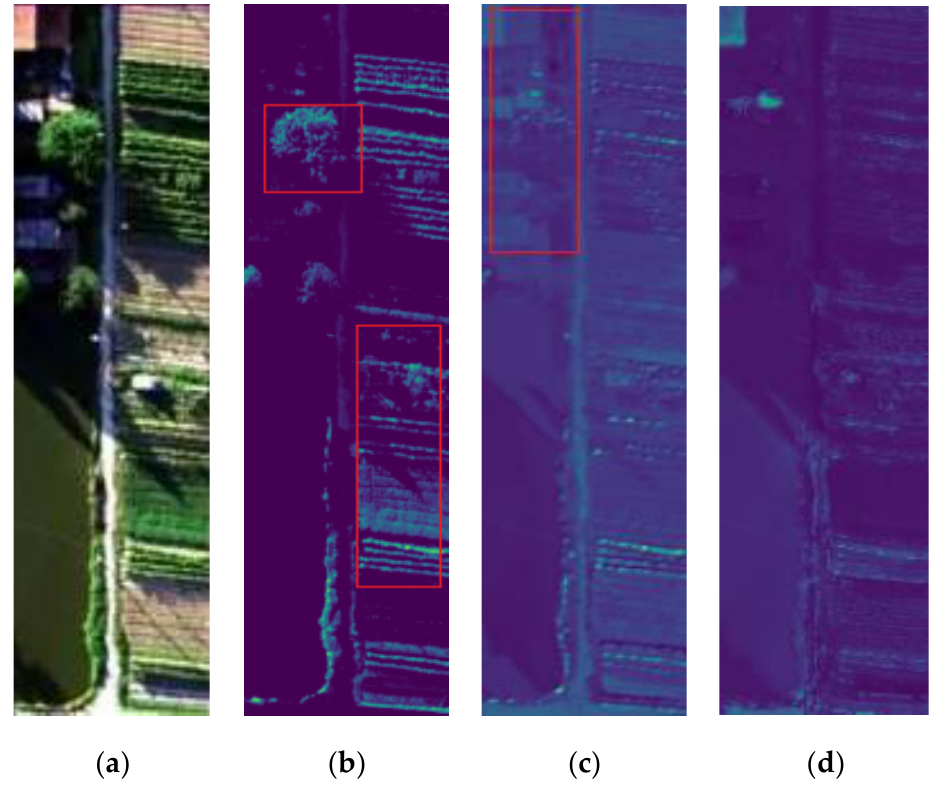
Figure 6. Feature output visualization. ( a ) HSI; ( b ) low level; ( c ) middle level; ( d ) high level.